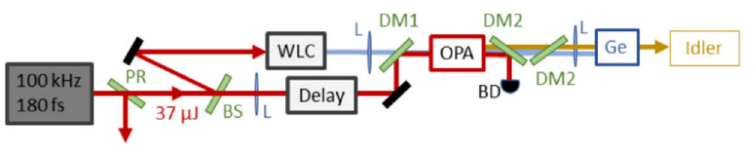
Figure 5. Illustration of BGS OPA laser system. BS, beam sampler; PR, partial reflector; WLC, white light continuum generation unit; L, lens; BD, beam dump. DM1, dichroic mirror, high reflection (HR) at 1.03 μ m and high transmission (HT) at >1.1 μ m; DM2, dichroic mirror, HR at 1.0–1.2 μ m and HT at 6–12 μ m; OPA, LGS or BGS crystal; Ge, germanium-based temporal chirp compensation unit. Reprinted with permission from [33].